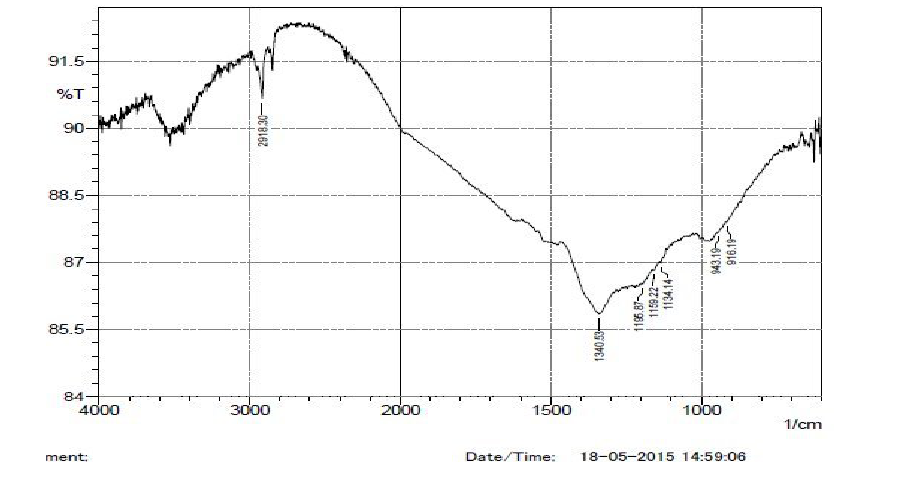
Fig. 8. FTIR patterns of Bio-AgNP Fig 8 FTIR patterns of Bio-AgNP. Table 2 Dose dependent antibacterial activity of Bio AgNP Table 2 Dose dependent antibacterial activity of Bio AgNP